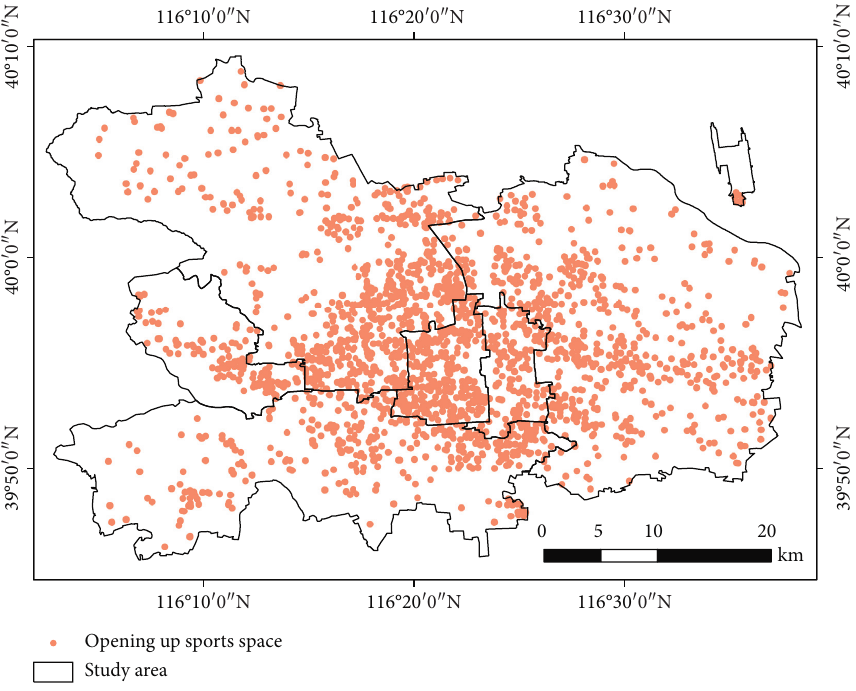
Figure 1: Distribution of community fitness service